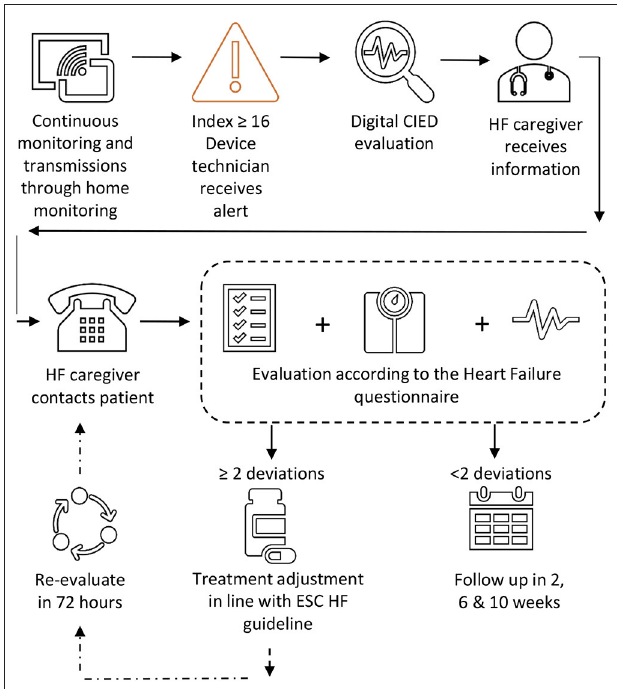
FIGURE 1 | Heart failure care